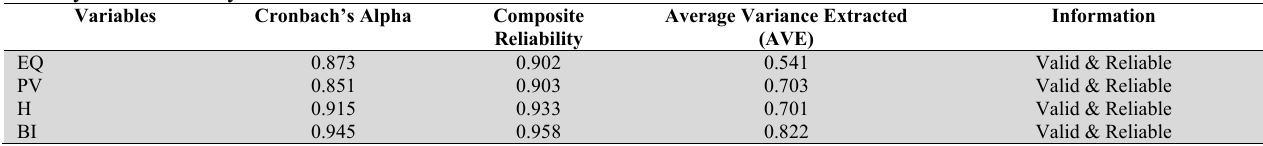
Validity and Reliability Test Results